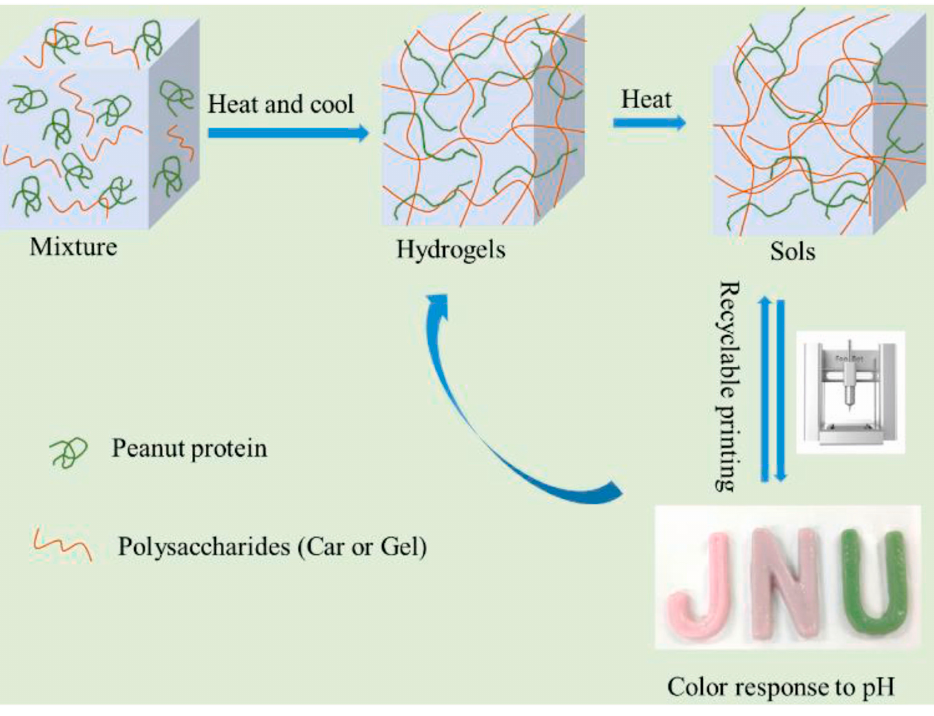
Figure 11. Schematic diagram of peanut protein-polysaccharide semi-interpenetrating network hydrogel fabrication and 3D printing. Picture taken from an article by et Lin et al. [70].